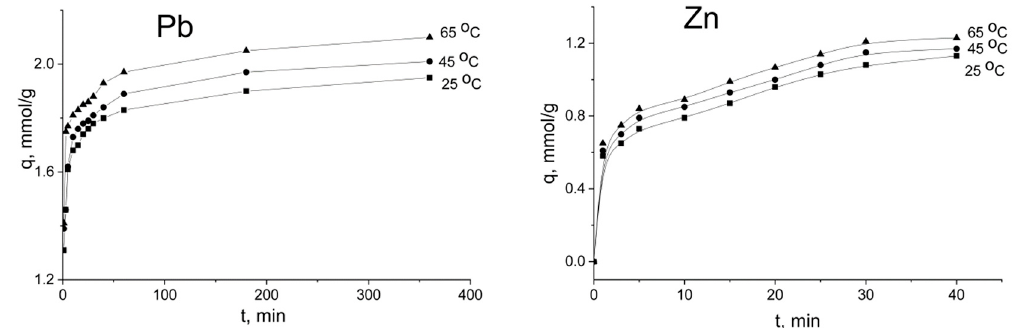
Figure 8. Sorption kinetics of lead and zinc ions at 25–65 ◦ C on titanium phosphate (the initial concentration of Pb 2 + and Zn 2 + ions was 10 mmol · L − 1